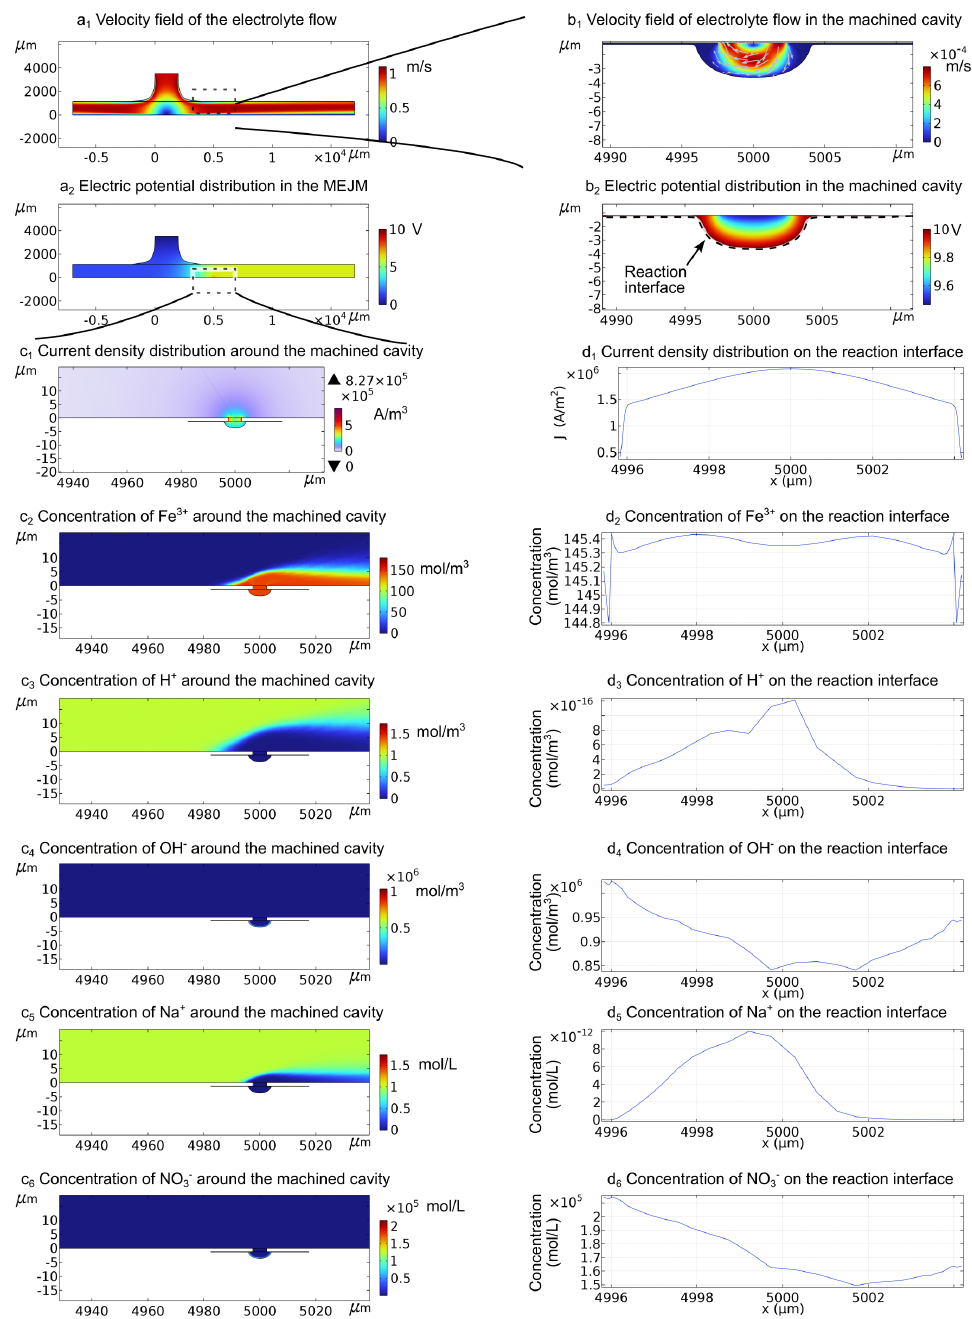
Figure A2. Simulation results at t = 1 s. ( a 1 ): velocity field of the electrolyte flow; ( b 1 ): velocity field of electrolyte flow in the machined cavity; ( a 2 ) electric potential distribution in the MEJM; ( b 2 ) electric potential distribution (V) in the machined cavity; ( c 1 ) normal current density distribution around the machined cavity; ( d 1 ): normal current density distribution on the reaction interface; ( c 2 – c 6 ): concentration ( mol/m 3 ) of Fe 3+ , H + , OH – , Na + , and NO 3– around the machined cavity; ( d 2 – d 6 : concentration (mol/m 3 ) of Fe 3+ , H + , OH – , Na + , and NO 3– on the reaction